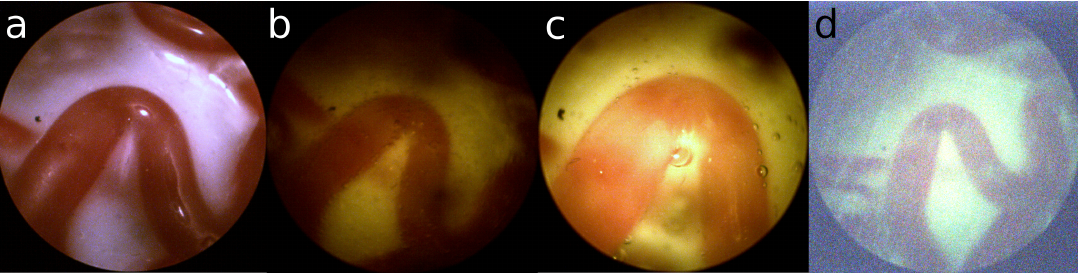
Figure 1. ( a ) Ex-vivo view; ( b ) uneven distribution of light; ( c ) too much light saturating the sensor; ( d ) not enough light creating sensor noise.